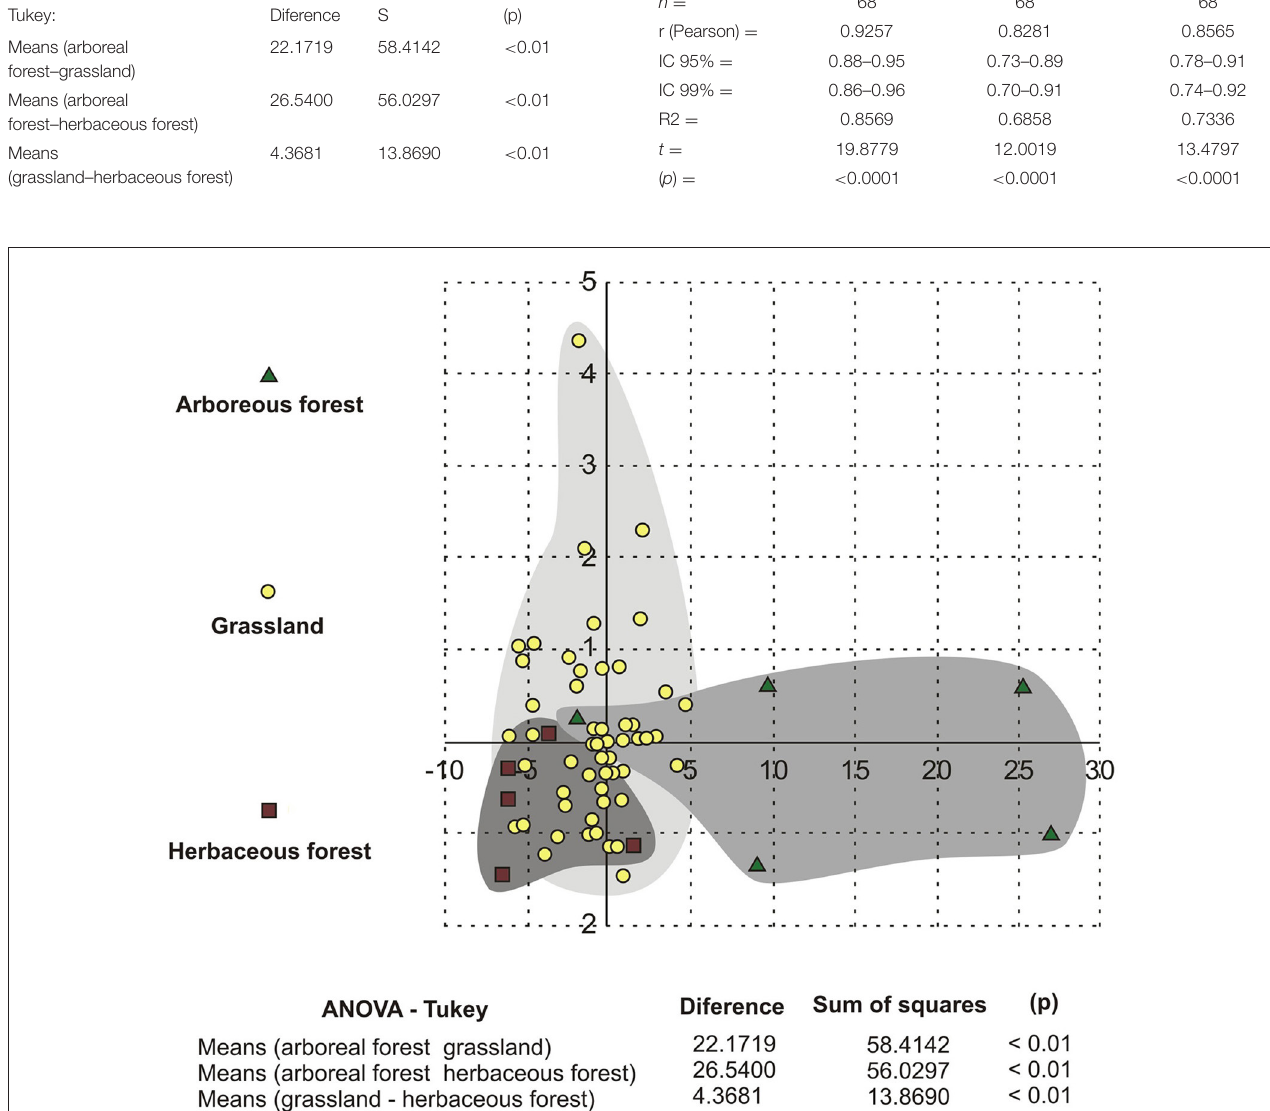
FIGURE 10 | Discriminant analysis of the pollen grain size ordination of the 68 Poaceae species.